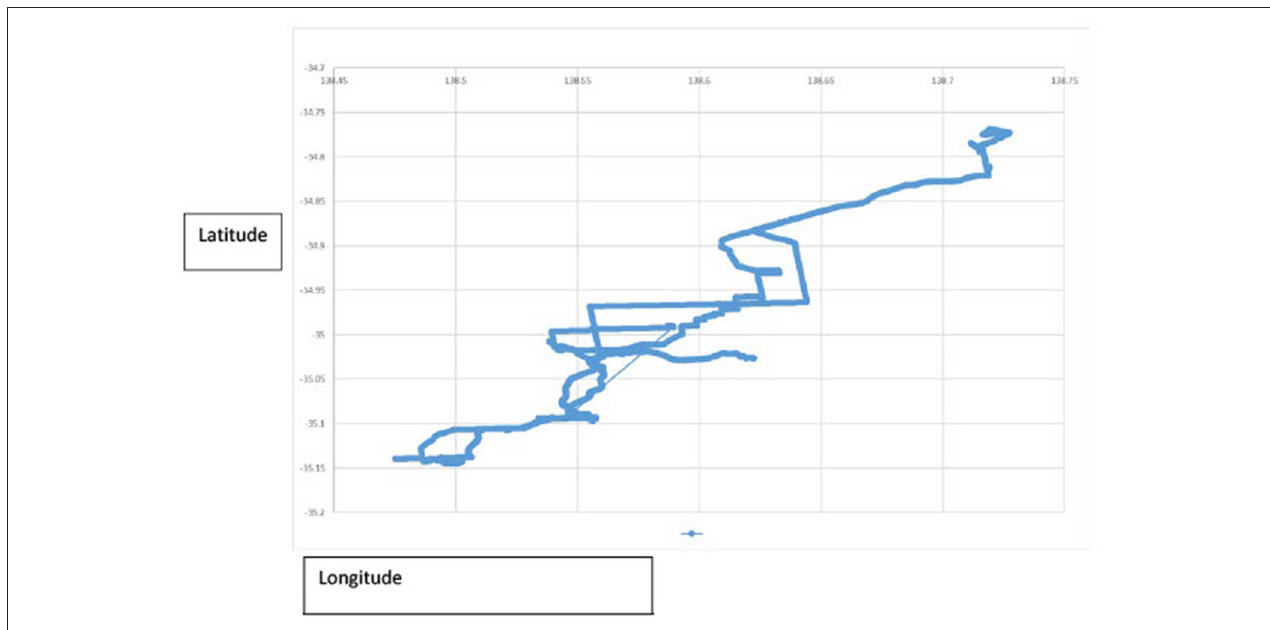
FIGURE 2 | Global positioning system data.